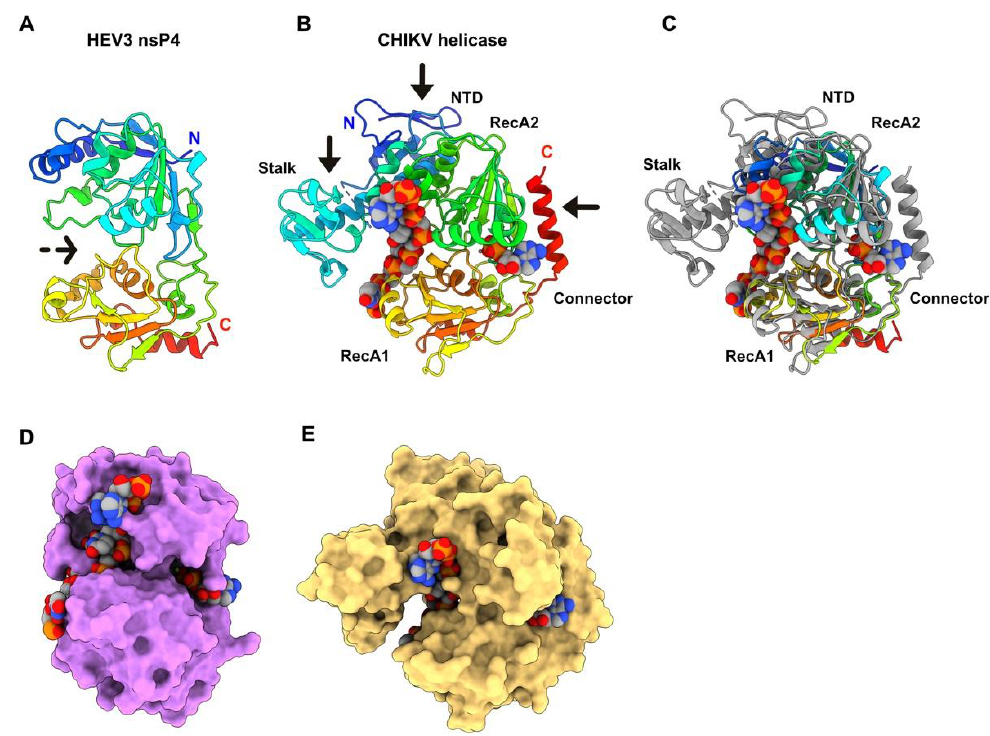
Figure 5. HEV-3 nsP4 predicted structure, a helicase. ( A ) Ribbon representation of HEV-3 nsP4 predicted structure (rainbow colored). The dotted arrow indicates the internal crevice. ( B ) Ribbon representation of CHIKV helicase with labelled domains. The arrows point to the parts missing in HEV-3 nsP4. The ADP-AlF 4 and ssRNA molecules are atom colored and shown as spheres (C: grey; O: red; N: blue; P: orange). ( C ) Superimposition of HEV-3 nsP4 helicase (rainbow) and CHIKV helicase domain (grey). The ADP-AlF 4 and ssRNA are atom colored and shown as spheres. ( D ) Surface representation of HEV-3 nsP4 with ADP-AlF 4 and ssRNA in the same position as in the CHIKV helicase, after superimposition of HEV-3 nsP4 and CHIKV helicase onto each other (in C). ( E ) Surface representation of CHIKV helicase with bound ADP-AlF 4 and ssRNA.